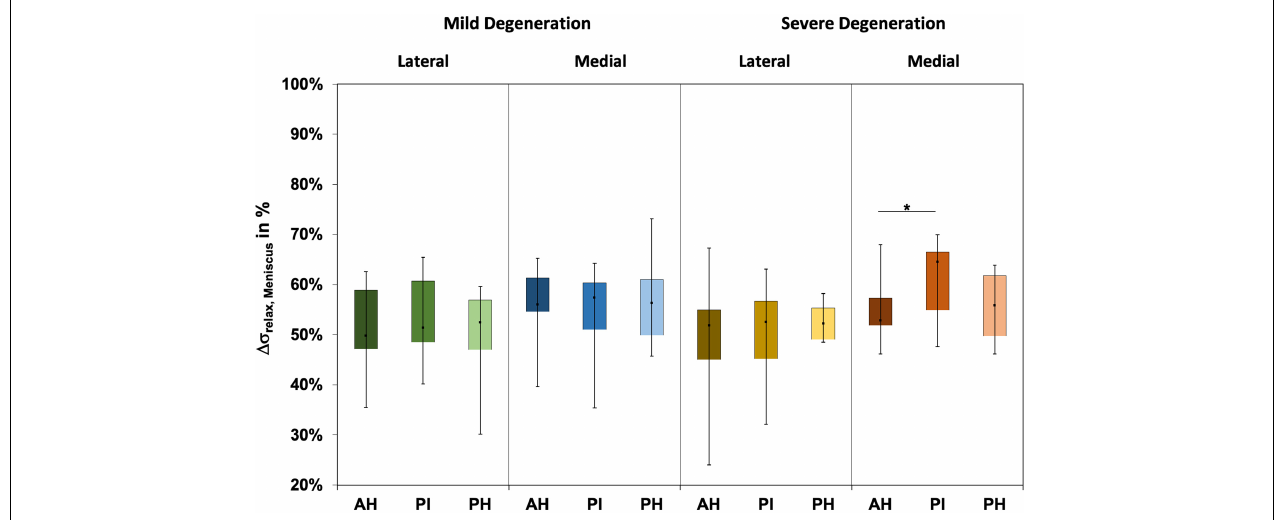
FIGURE 3 | Box plots (minimum, maximum, median, and 25th and 75th percentiles) of the relaxation percentages over the maximum stress ( (cid:49) σ relax ) of the mildly and severely degenerated menisci. Subdivided anatomical regions are: AH, anterior horn; PI, pars intermedia; PH, posterior horn. Non-parametric statistical analyses: n = 12; * p <